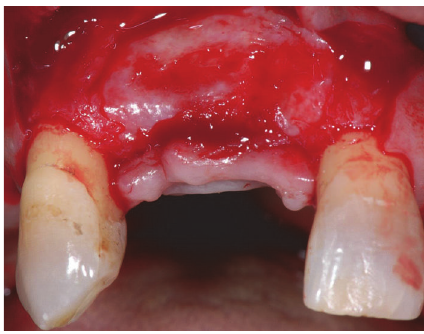
Figure 2: At 4 months the extraction sockets were completely filled by uniform radiodense bone tissue. Note the ridge morphology mimicking the space created beneath the